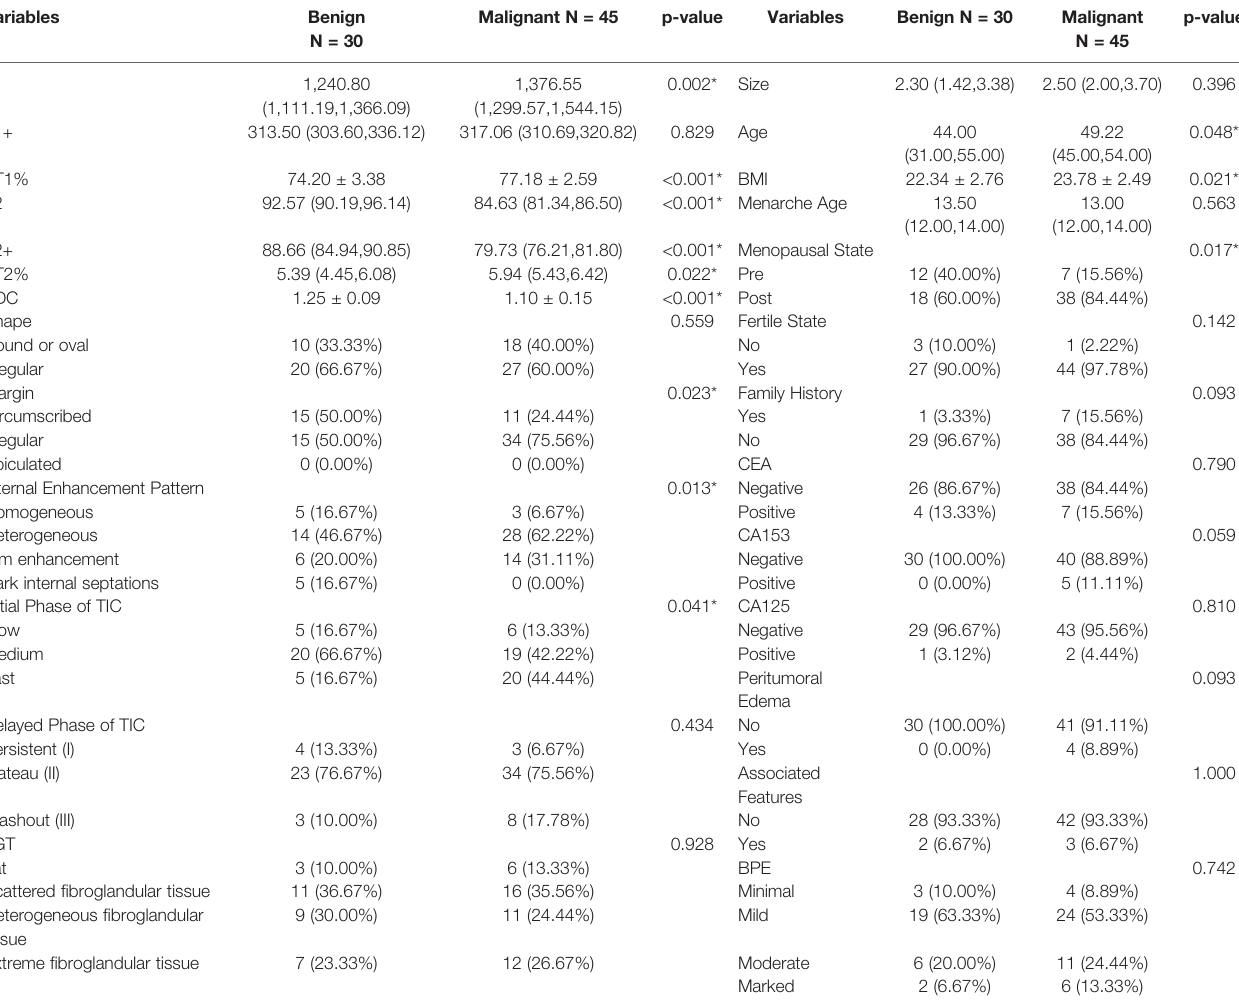
TABLE 2 | Comparison of clinical and imaging characteristics between benign and malignant groups.